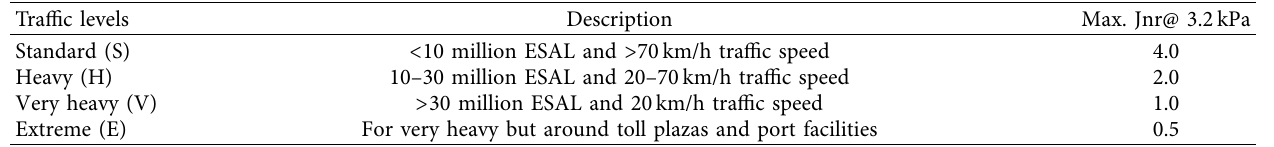
Table 2: Jnr based PG grading requirements [47].